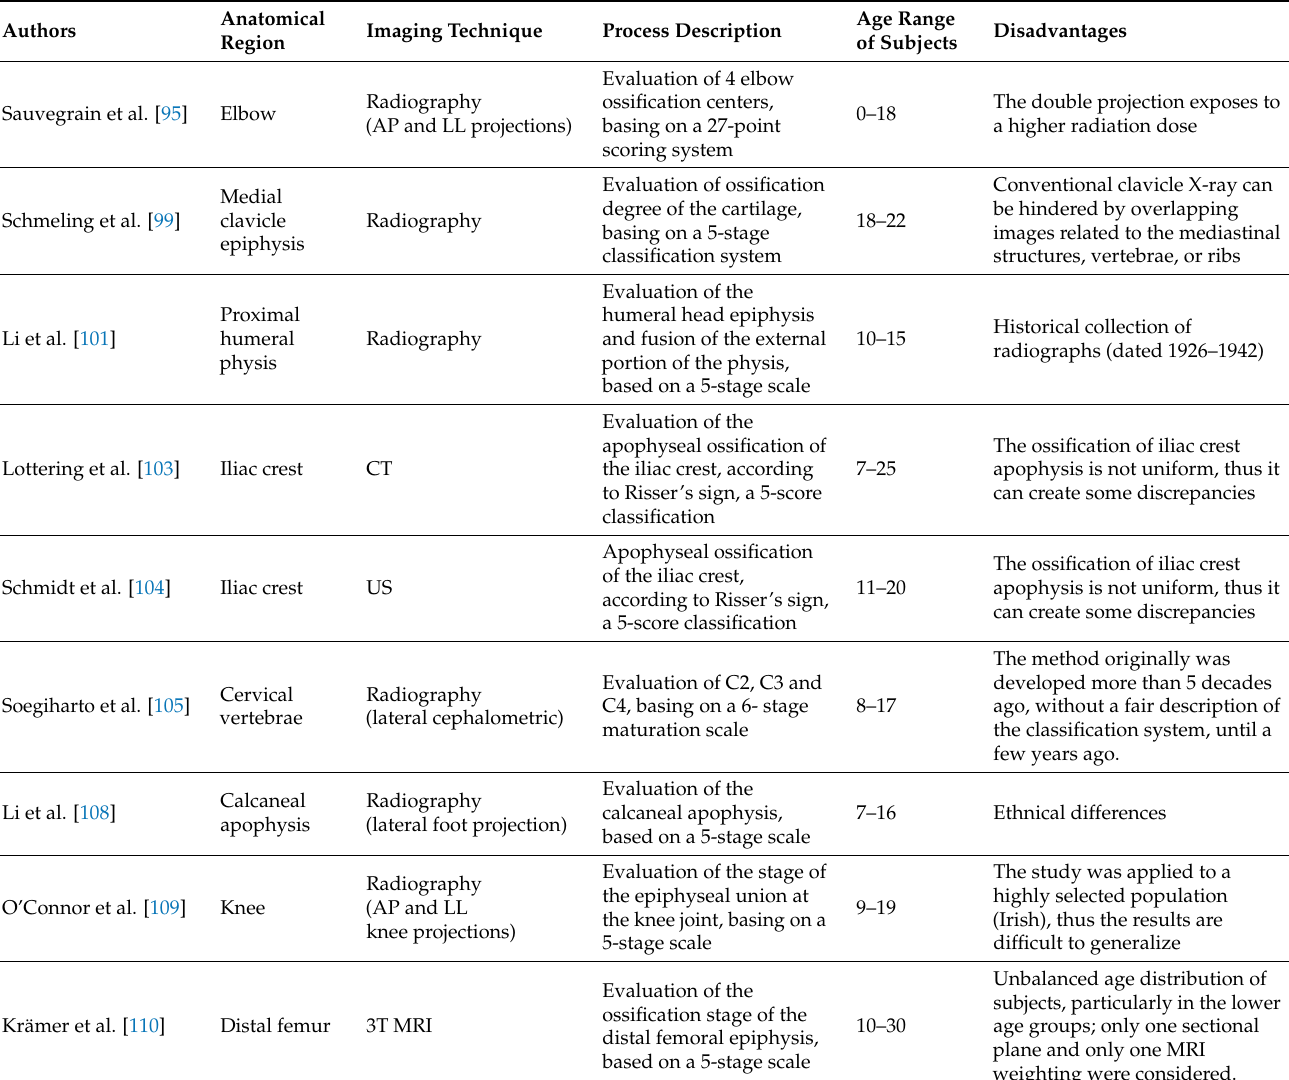
Table 4. The different methods for bone age estimation based on the analysis of different skele- tal